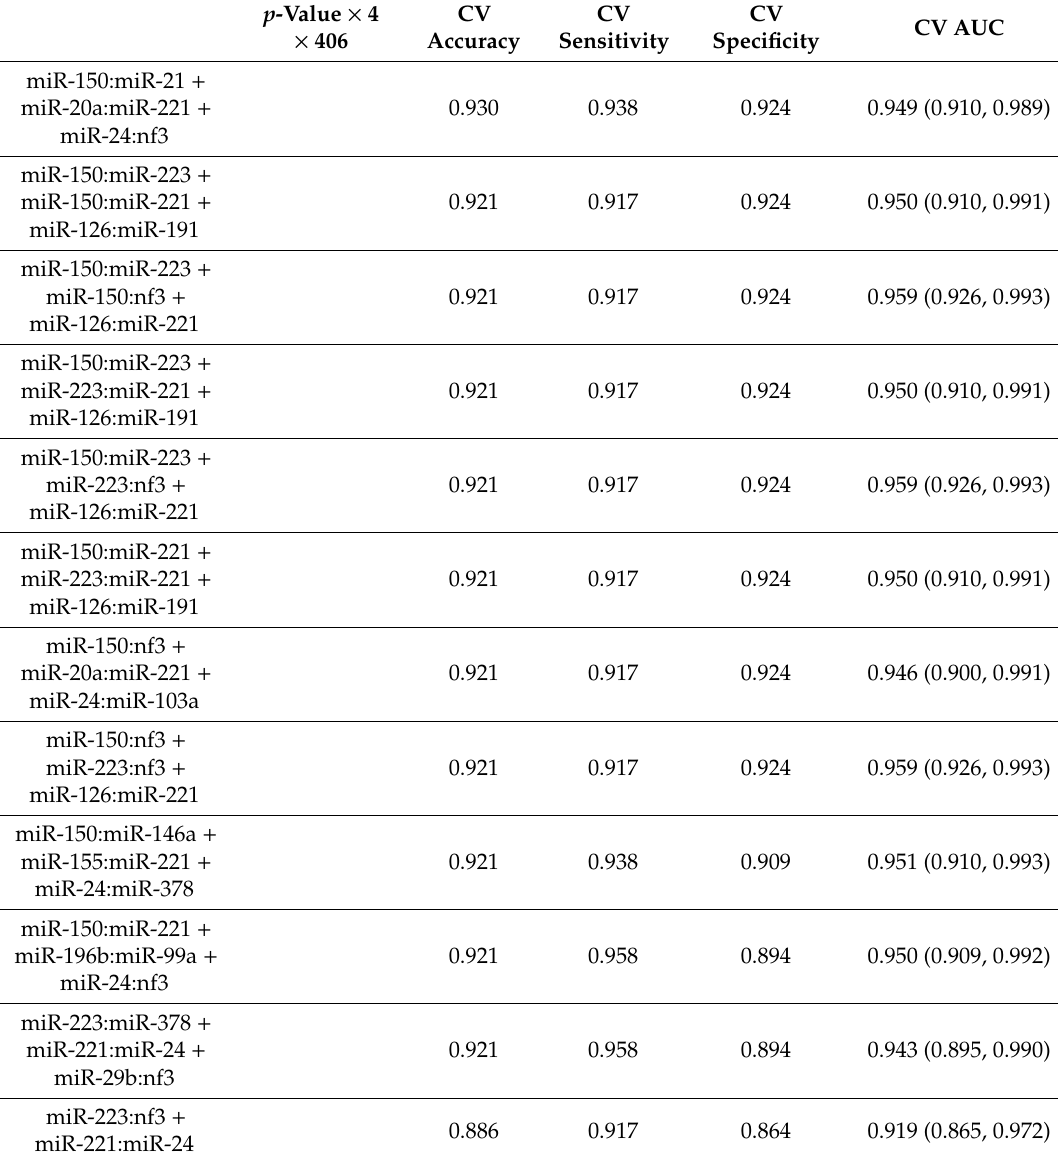
Table 2. Comparison of NTP vs.